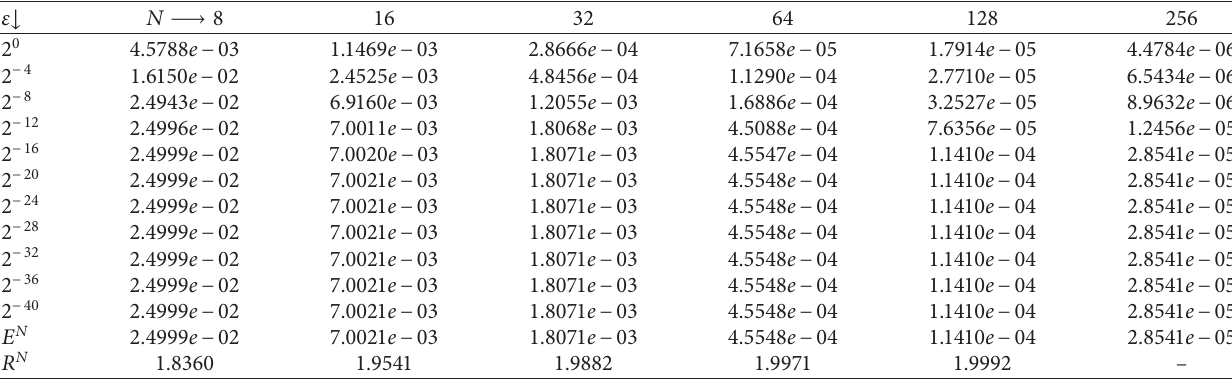
Table 8: Maximum absolute error of Example 4 after Richardson extrapolation for δ � 0 . 6 ε and η � 0 . 5 ε .